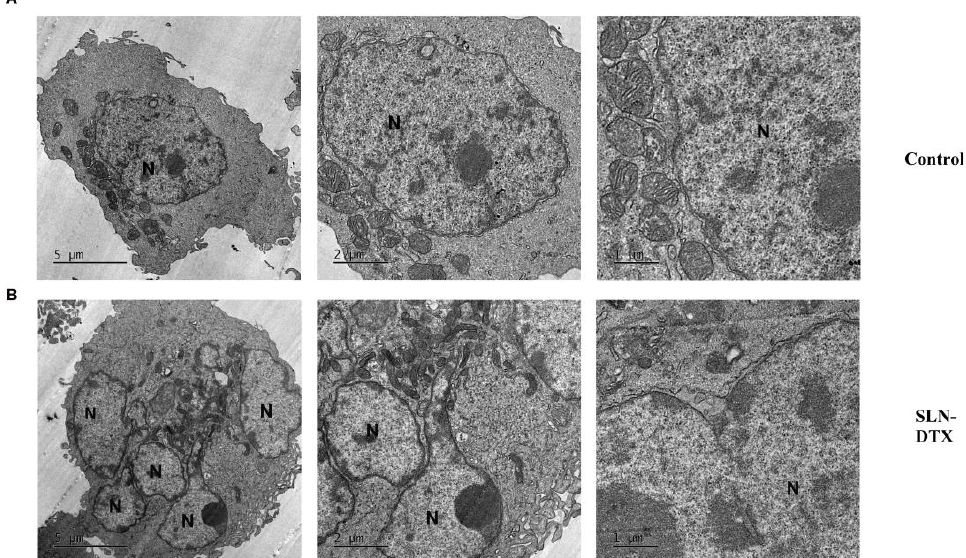
Figure 6. Transmission electron microscopy of MDA-MB-231 after 72h treatment with SLN-DTX and the control. ( A ) MDA-MB-231 control cells and ( B ) MDA-MB-231 treated with SLN-DTX after 72h. N: nucleus. Observation of segmented nucleus, characteristic multinucleation after treatment with SLN-DTX. At higher magnification, it is possible to observe that the nuclear segments are delimited by the nuclear envelope.